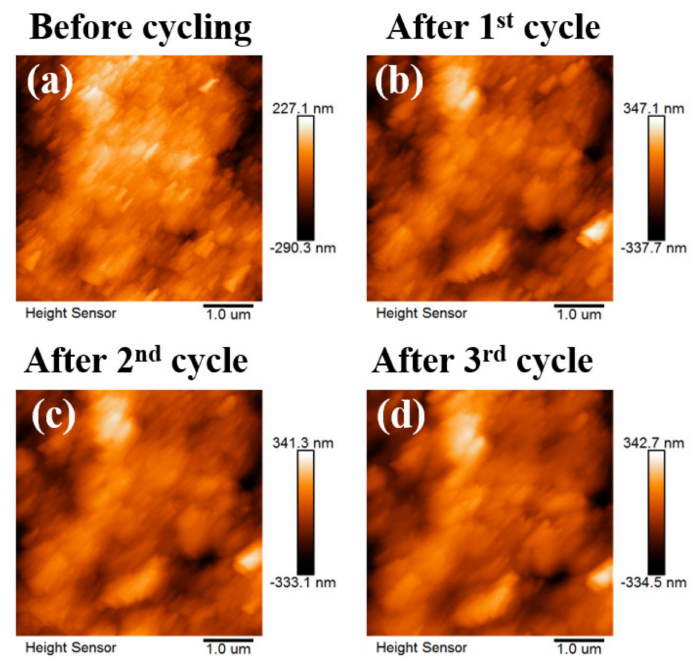
Figure 3. In situ AFM images of electrolyte E3 in LMR material (5 µ m × 5 µ m). ( a ) AFM images of LMR particles in air before cycling. ( b – d ) AFM images of LMR particles in the electrolyte after first, second, and third CV cycle.